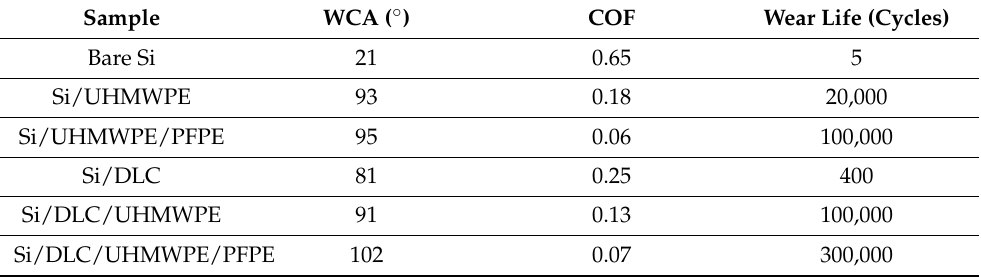
Table 3. Summary of results for different samples with the thickness of UHMWPE fixed at 28 µ m. Wear tests conducted a normal load of 40 mN and a sliding speed of 0.052 m/s [54].